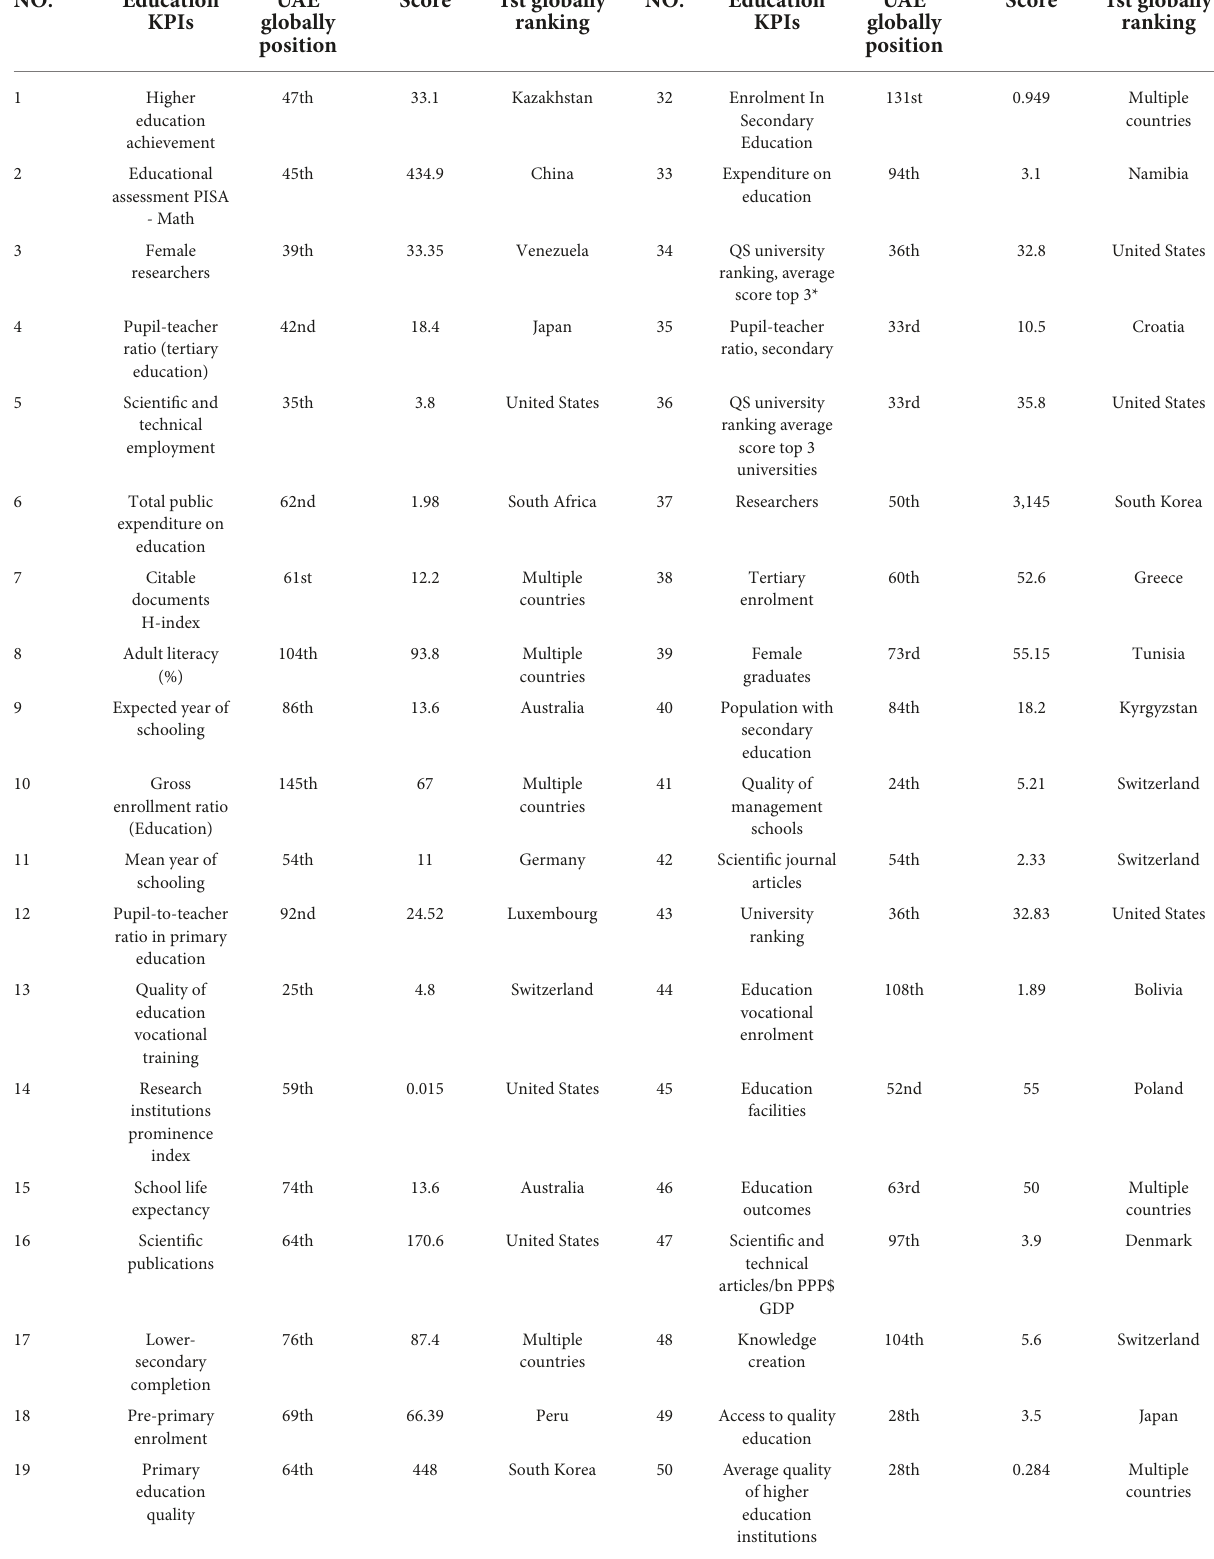
TABLE 4 Global ranking of education key performance indicator (KPI) Vs UAE.